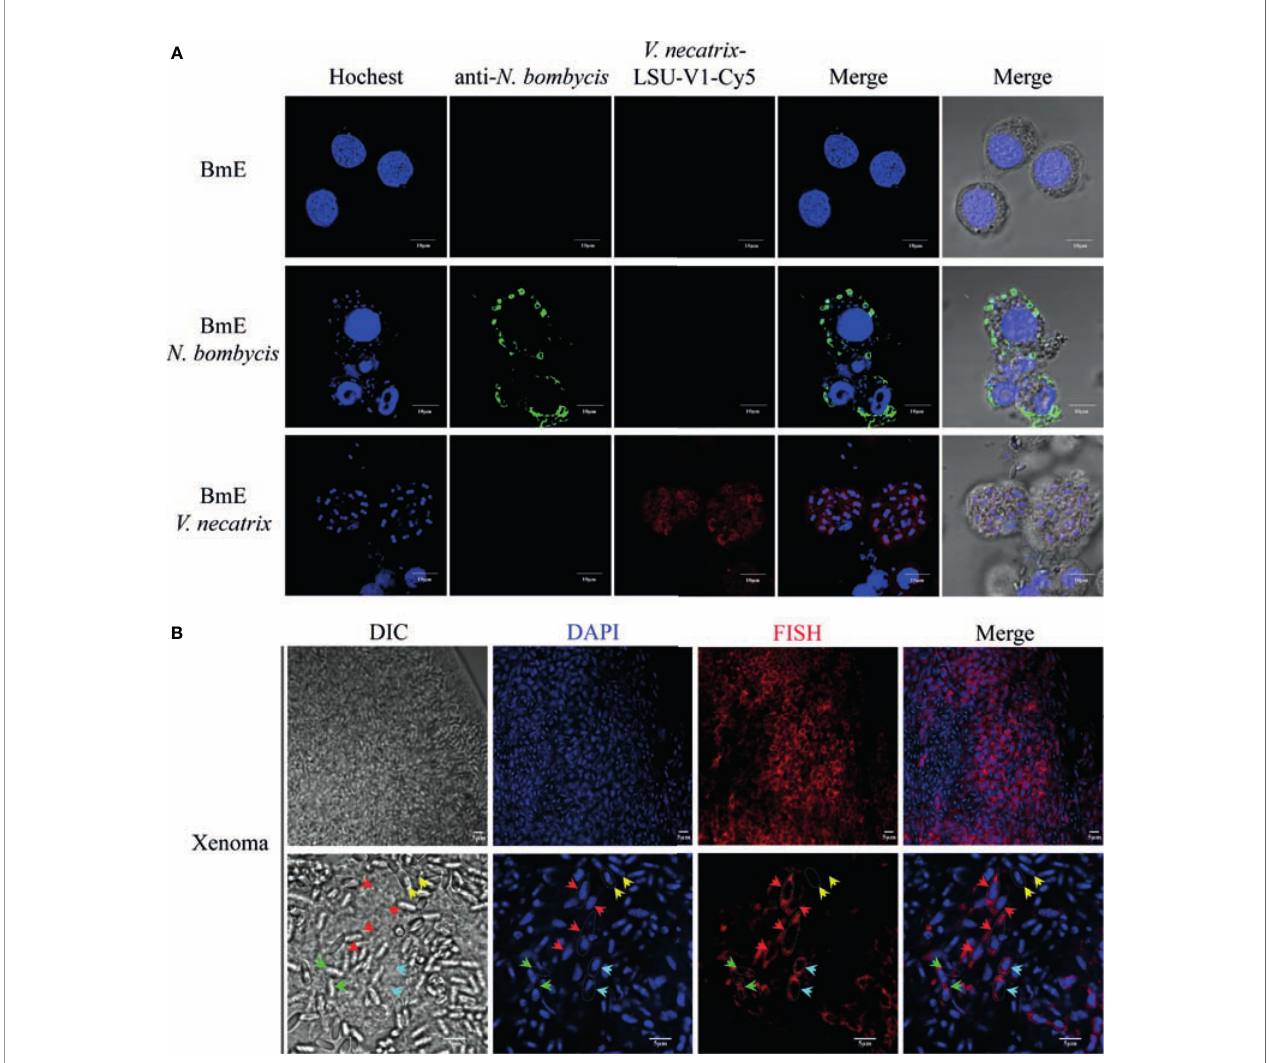
FIGURE 2 | FISH and DAPI staining of V. necatrix BM in xenoma. (A) The parasite purity was veri fi ed by FISH with a probe of V. necatrix ribosomal RNA (red) and IFA using an antibody against N. bombycis (green) in infected BmE cells, respectively. Bar, 10 µm. (B) The nucleus of V. necatrix BM in all stages was stained with DAPI (blue). The parasites in development were labeled using FISH with a probe of the ribosomal RNA (red). Red arrowhead, meront; Cyan arrowhead, sporont; Yellow arrowhead, mature spore; Green arrowhead, empty (germinated) spore; Bar, 5